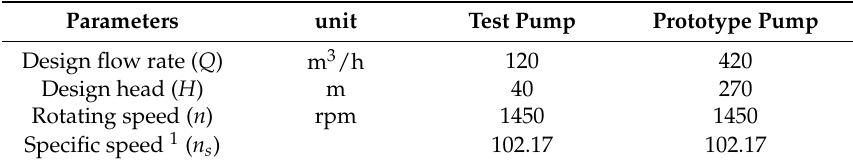
Table 2. Test pump and prototype pump performance parameters.